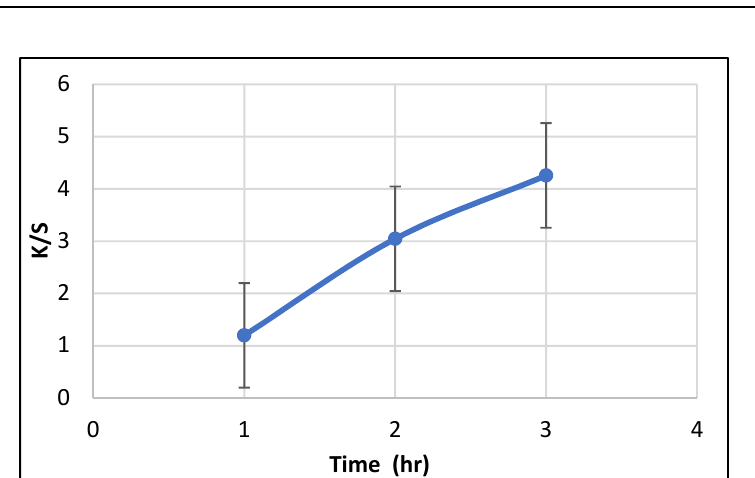
Figure 8. Effect of treatment temperature on color strength (K/S). 3.2.4. Exhaustion of SeNPs into PP Fabric The treatment solution was sampled before and after treatment to measure the SeNPs exhaustion. Moreover, the absorbance of SeNPs solution was measured by using UV/VIS spectrophotometer-model: Alpha-1860. Figure 9 showed the absorbance of SeNPs concen- tration before and after exhaustion by PP fabric in the wavelength ranges from 200 to 700 nm. The absorption spectrum of SeNPs-PP fabric before exhaustion shows a sharp absorp- tion band at 263 nm, indicating the presence of SeNPs. After exhaustion, remarkable de- crease in the absorbance of the treatment solution can be attributed to the low ratio of SeNPs as it was absorbed by PP fabric.